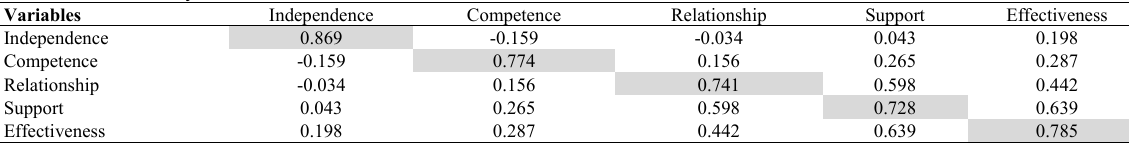
Note: Square roots of average variances extracted (AVEs) shown on